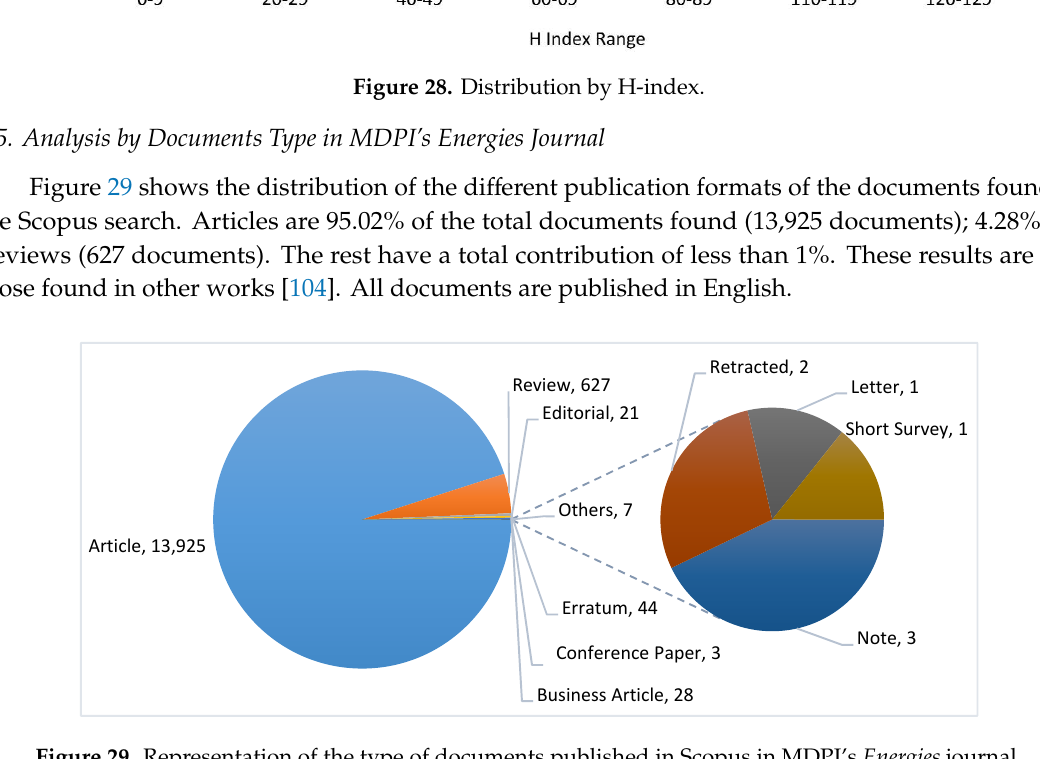
Figure 29. Representation of the type of documents published in Scopus in MDPI’s Energies journal.